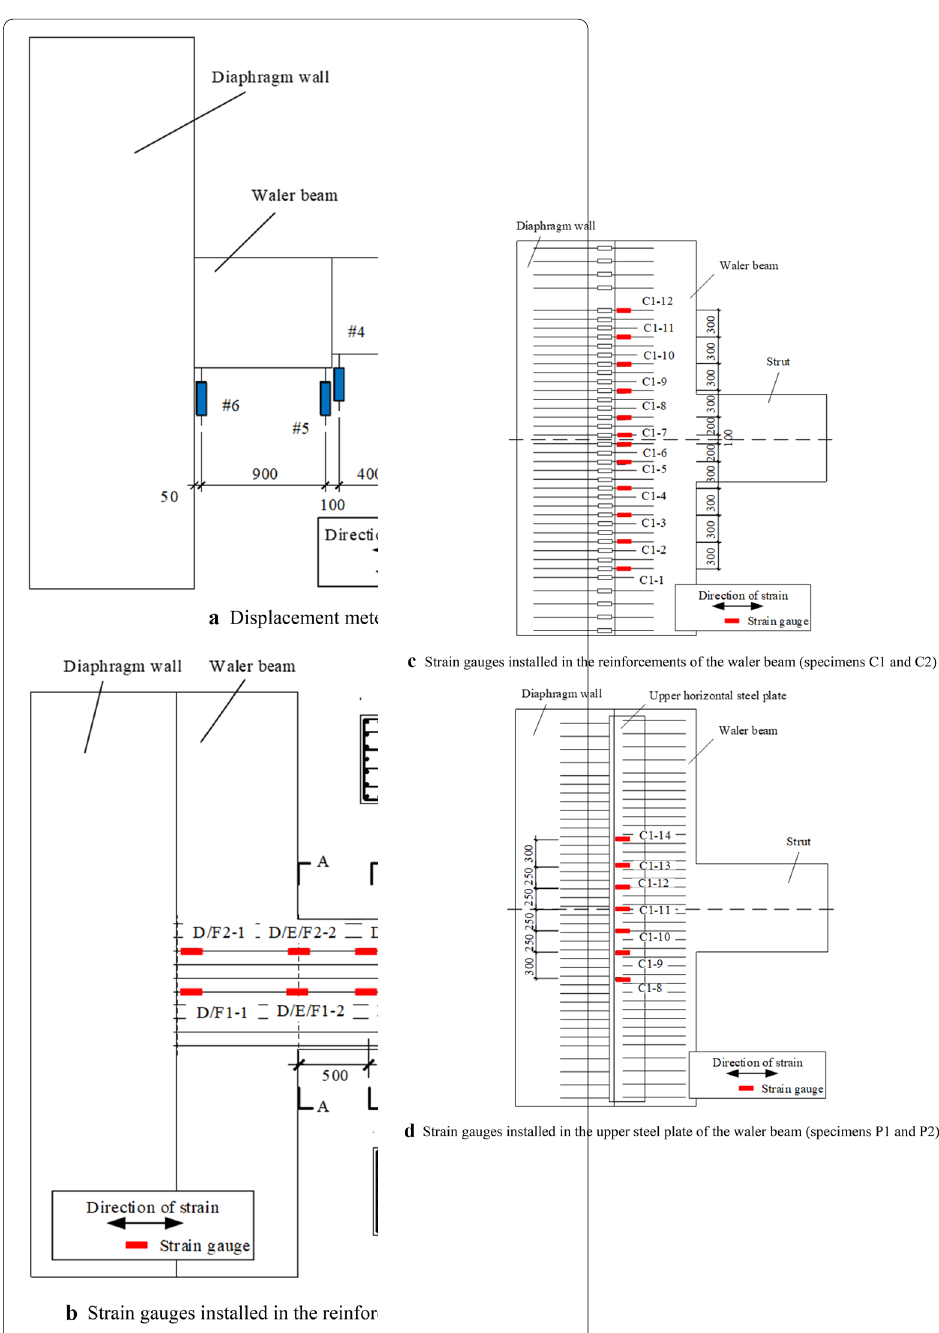
Fig. 9 Instrumentation layout of the test